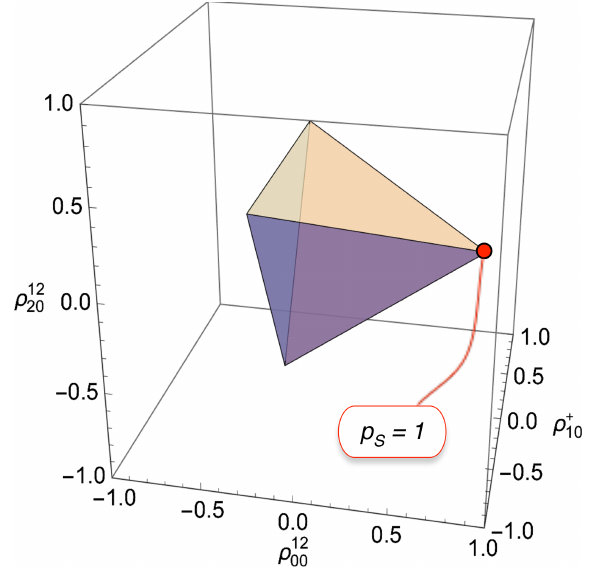
, Figure 3. Physical bounds on the rank-0 polarization moment ρ 12 00 the rank-1 polarization moment ρ + , and the rank-2 polarization 10 moment ρ 12 for spin-1/2 pairs. The shaded tetrahedron shows the 20 physically accessible region. The vertices correspond to pure-state density operators for each of the four singlet or triplet states. The annotation shows the vertex for exclusive population of the singlet state (corresponding to pure parahydrogen in the case of H 2